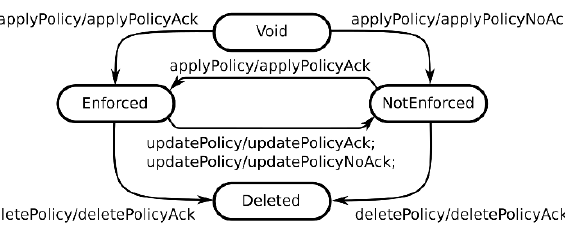
Figure 11. Model representing the rail policy lifecycle supported by the TTICU.